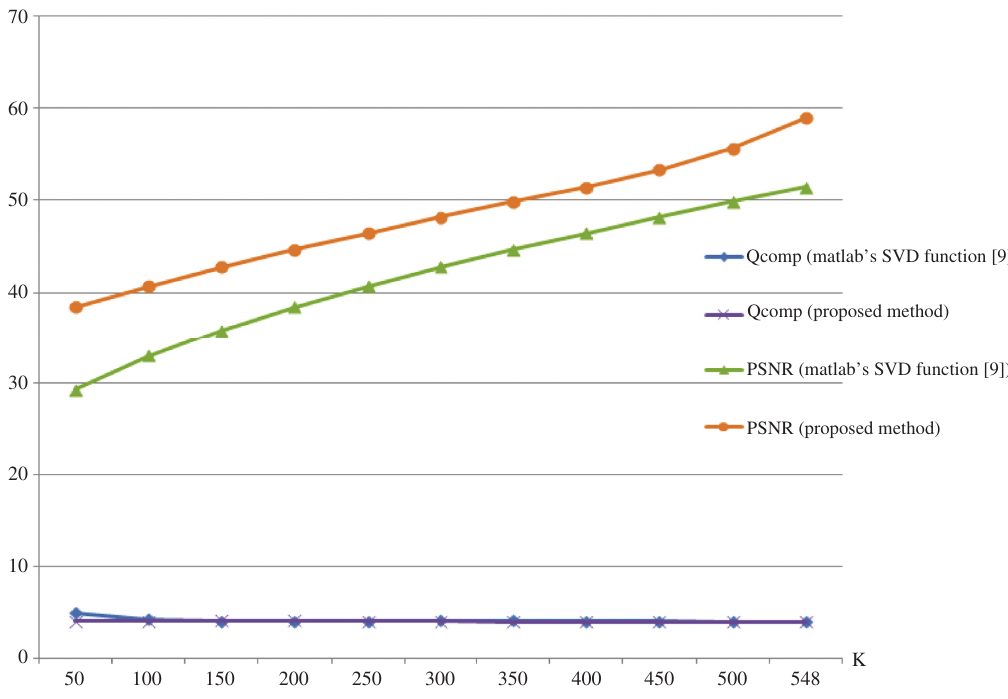
Figure 12: Relation between Image Rank, Compression Ratio, and PSNR for grayscale.jpg 1280 × 960,